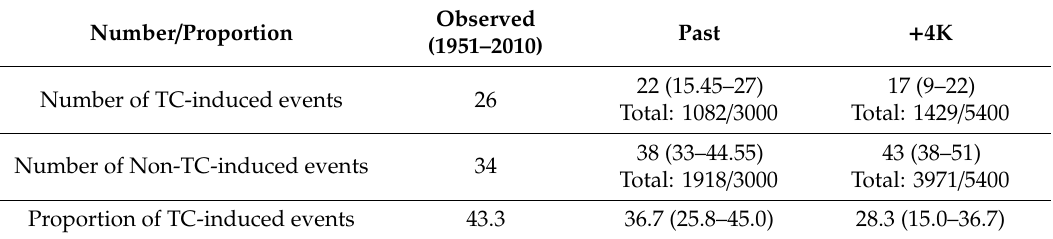
Table 1. The number of TC-induced and non-TC-induced events within each annual maximum 72 h rainfall event over the TKC basin (lines 1 and 2). The proportions (%) of TC-induced events are shown in Line 3. Median values of the ensemble members are shown (the 5th and 95th percentile values of the ensemble members are within the parenthesis). The number of total events in the Past and + 4K experiments are shown in lines 1 and